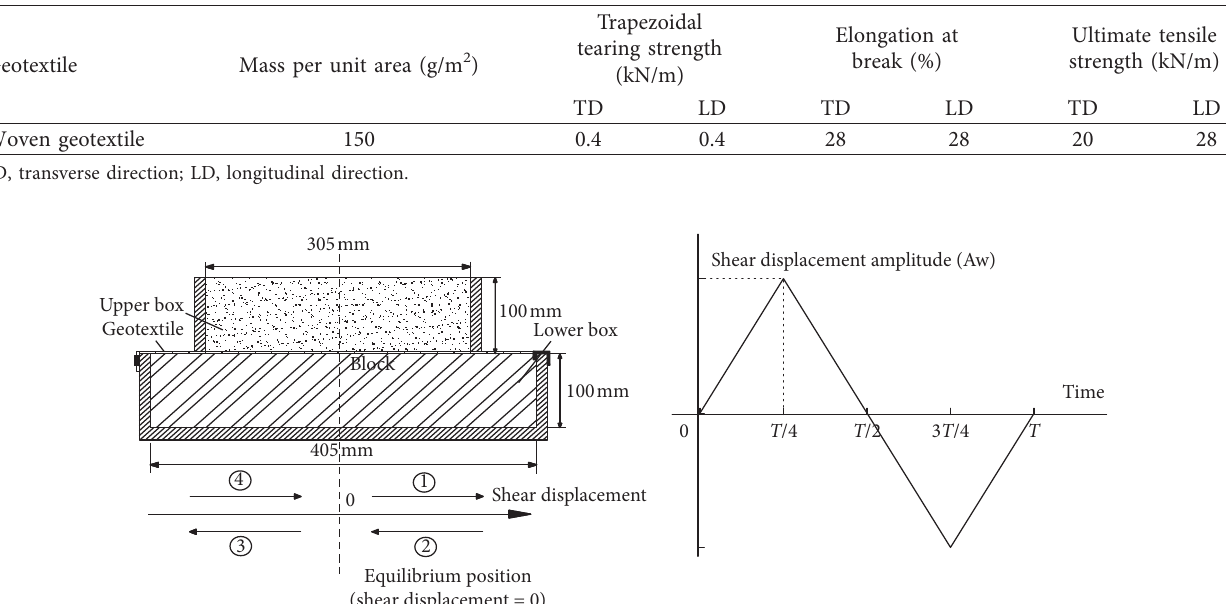
Table 1: Main characteristics of the geotextile.